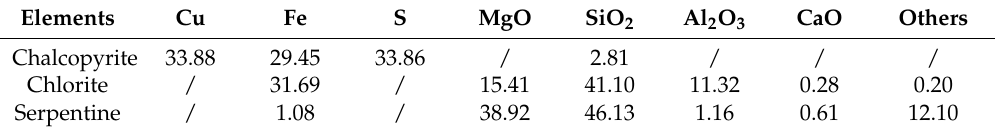
Figure 2. XRD spectra of the chalcopyrite ( a ), chlorite ( b ), and serpentine ( c ) samples Table 1. Chemical compositions of chalcopyrite, chlorite, and serpentine.